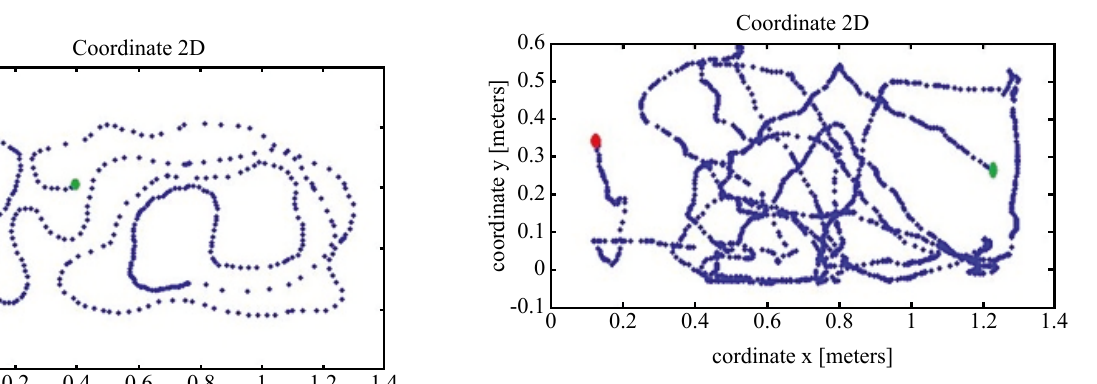
Figure 3. Image of the tracing of one rat in the enriched environment during the 10 minutes screening. Green dot = beginning of the trace; red dot = end of the